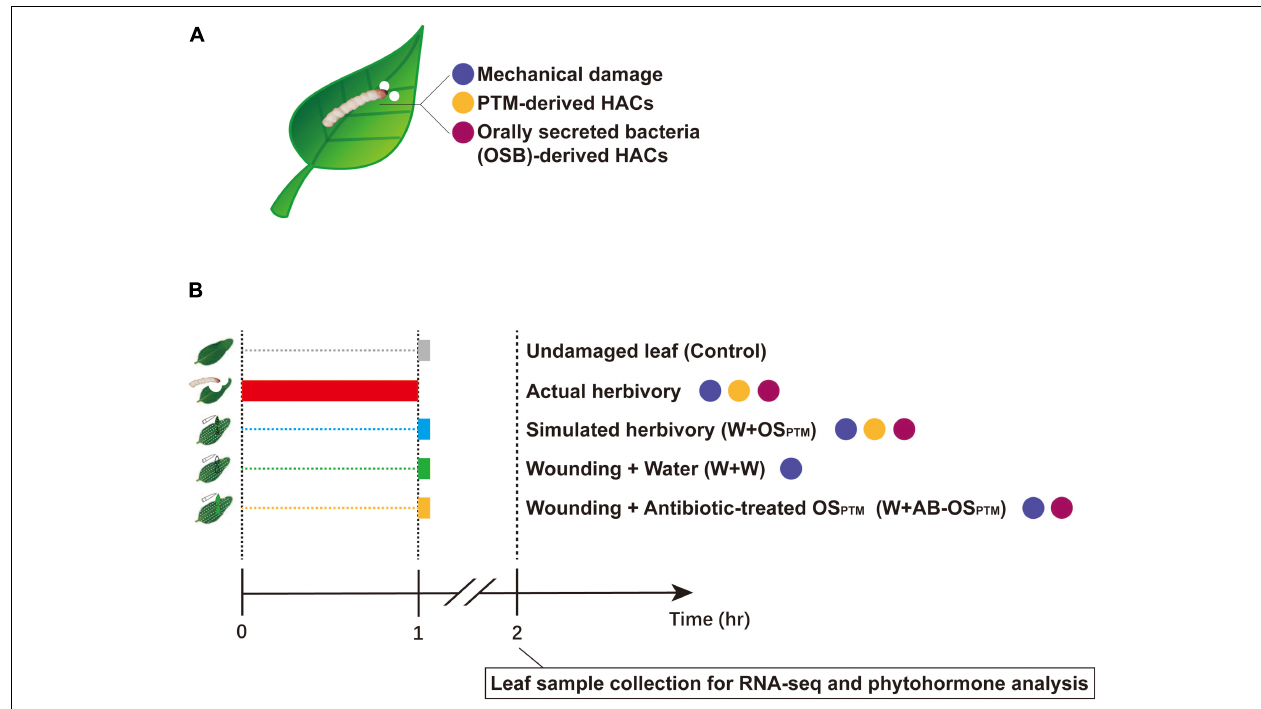
FIGURE 1 | Breaking down PTM herbivory and reorganizing its components. (A) PTM herbivory contains three types of stimuli: mechanical damage, PTM-derived HACs, and OSB-derived HACs. The differently colored dots refer to different types of stimuli. (B) The illustration of experiment setup: actual herbivory, W + OS PTM , W + W, and W + AB-OS PTM combine different types of stimuli as shown; in the actual herbivory group, potatoes were intensively treated with PTMs for 1 h and other treatment groups were simultaneously treated at the end of the actual herbivory treatment. All samples were collected at 1 h after simulated herbivory treatments and taken to RNA-seq and phytohormone